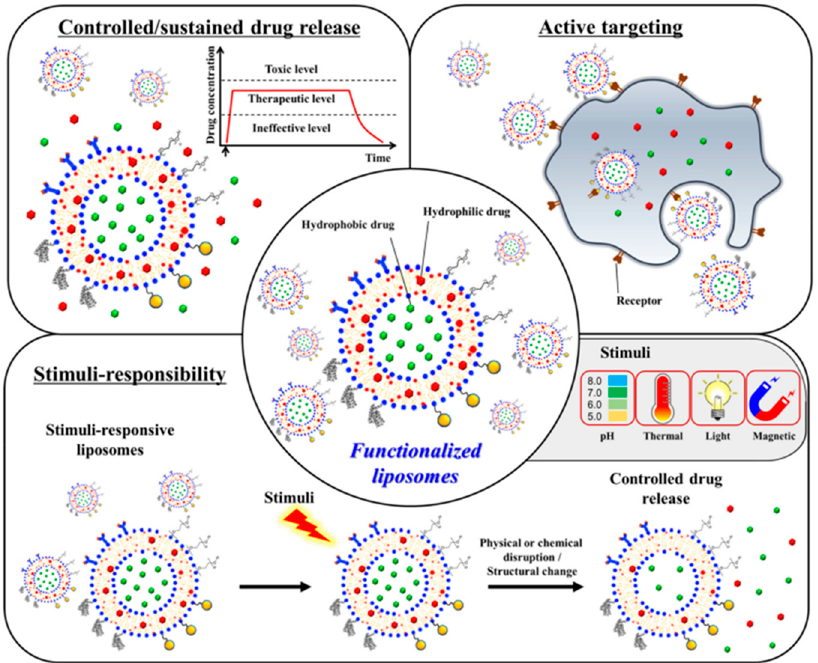
Figure 2. Scheme of functionalized liposomes used in bone regeneration applications. Liposomes have been designed for effective bone healing to store active targeting molecules, release medications in a regulated manner, and respond to stimuli [76]. Reprinted from an open access source. Conventional liposomes typically have significant concentrations of non-bioactive lipids such as cholesterol and phospholipids, which do not naturally promote bone regeneration. Our team has created an osteoinductive liposomal formulation using oxysterols as a component of liposomes to enhance standard liposomal formulations [77]. Oxysterols are a group of steroid derivatives that have been shown to promote ossification and osteogenesis [78]. One of the most effective oxysterols for bone regeneration, 20S-hydroxycholesterol, was added to non-phospholipid liposomes made of the single-chain amphiphile, stearyl amine (SA). When applied locally to the methacrylate glycol chitosan (MeGC) hydrogel scaffold, the integration of 20S-hydroxycholesterol into SA-liposomes efficiently stimulated in vitro osteogenesis and in vivo calvarial defect healing [79].